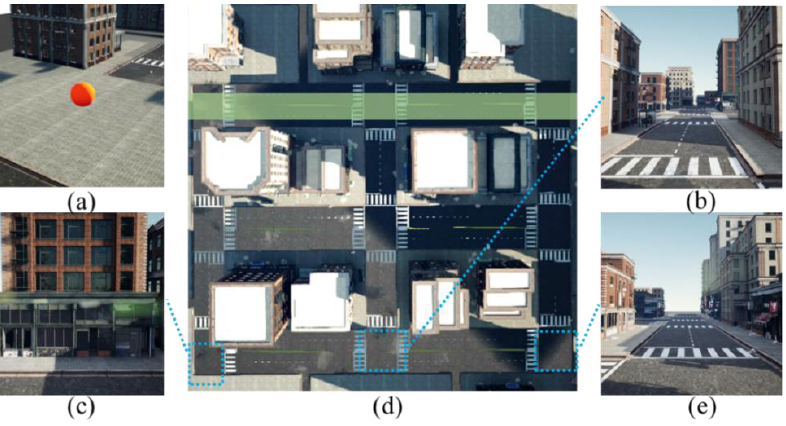
Figure 4. Experimental environment: ( a ) is the target, ( b , c , e ) is the initial positions of UAVs for scenario 1, ( d ) is the top view of the scene; the target position is restricted to the green zone. ( b ) is also the initial position of all UAVs for scenario 2.